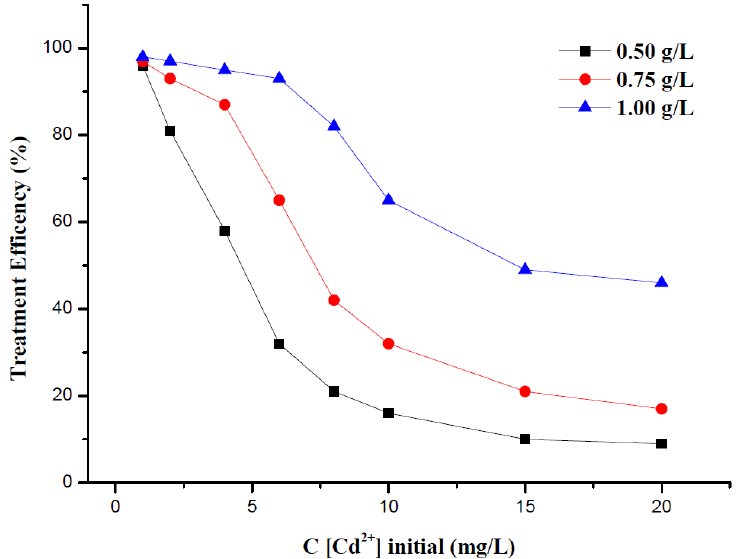
Figure 11. Original concentrations of Cd 2+ as a function of SNPs removal efficiency (T = 30 °C, pH = 5).